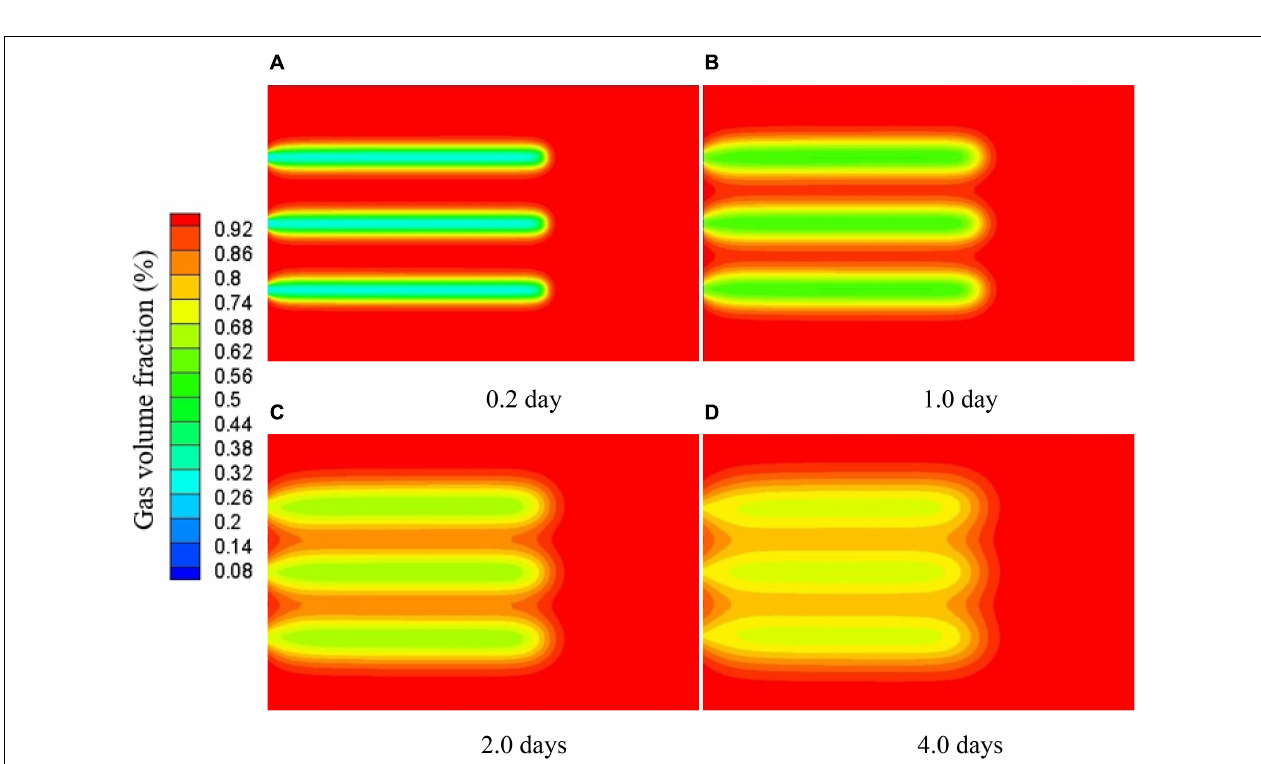
FIGURE 9 | Gas seepage fields of a 7.5-m slotted coal seam when λ = 1: (A) 2 days, (B) 1 day, (C) 2 days, and (D) 4 days.